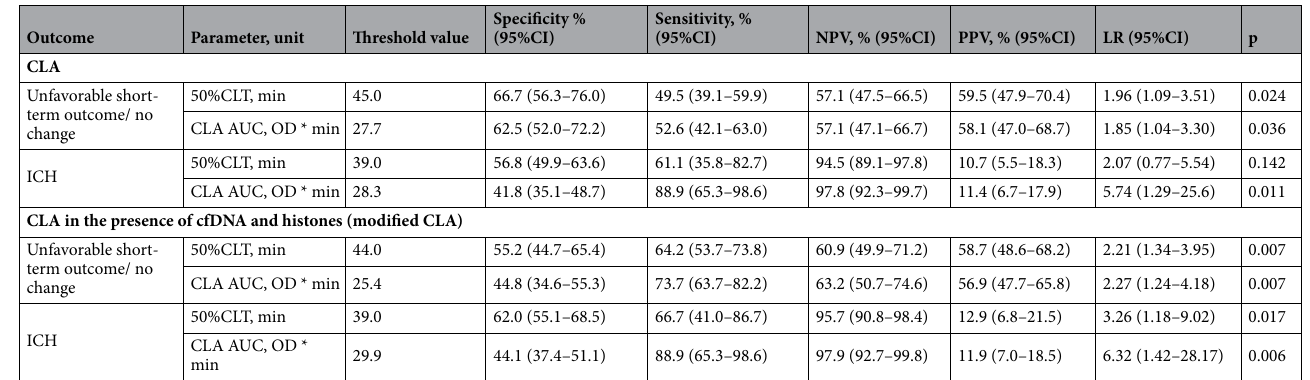
Table 5. Diagnostic performance of most relevant clot lysis assay (CLA) parameters in the absence/presence of cell-free DNA and histones, according to short-term outcome and safety of thrombolysis. Diagnostic performance is provided for the optimal threshold value, as determined according to the Youden-index. 95%CI: 95% confidence interval; cfDNA, cell-free DNA; CLA, clot lysis assay; CLA AUC, clot lysis assay area under the curve parameter; 50%CLT, 50% clot lysis time; ICH, intracerebral hemorrhage; LR, likelihood ratio; NPV, negative predictive value; PPV, positive predictive value. (ROC analysis, χ 2 test or Fisher’s exact test where